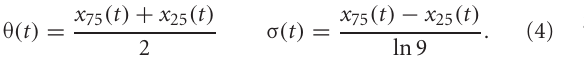
FIGURE 2 | Neuronal threshold and range dynamics. (A) Measurement of x 75 (yellow) and x 25 (purple) during 1h of double clamping an isolated neuron in vitro (see Methods in Wallach et al., 2011). The two measurements are highly correlated. The neuronal threshold θ (B) and the dynamic range σ (C) , were computed using Equation (4) (blue line in both). (D) When the measurements are displayed in the threshold/range state plane, the significant correlations between them is evident. Fitting with a linear relation